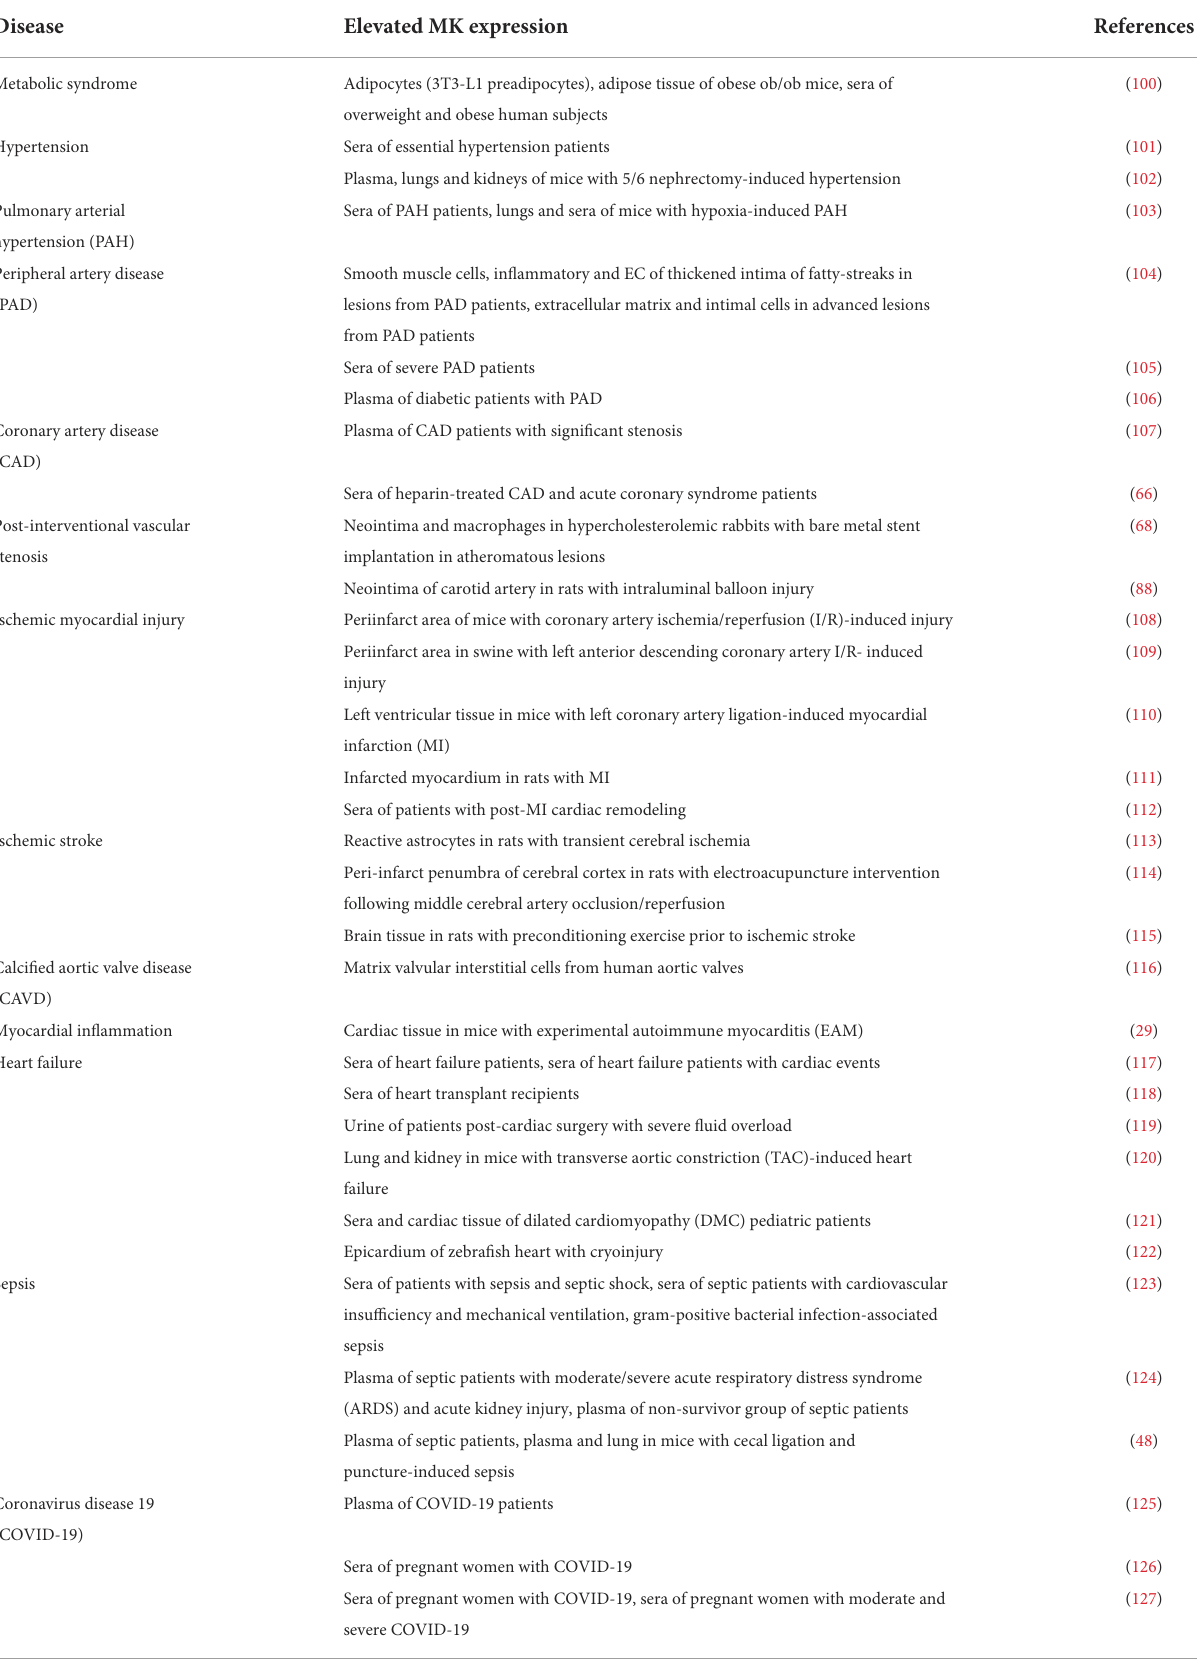
TABLE 2 MK expression in cardiovascular